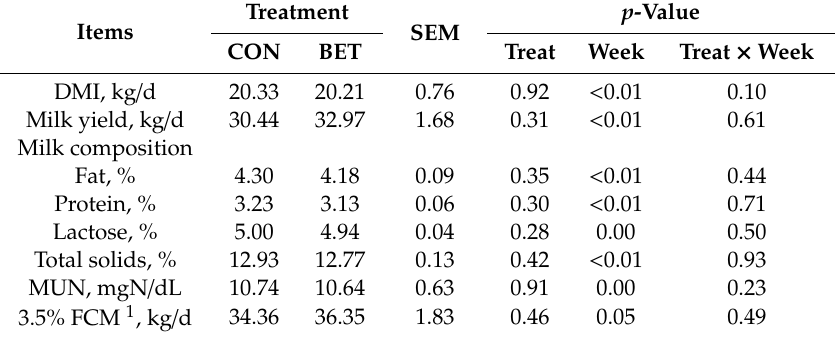
Table 2. Effectsofsupplementingcowswithoutrumen-protectedbetaine(CON)orwithrumen-protected betaine (BET) on dry matter intake, lactation performance, and body weight change during the first six weeks of